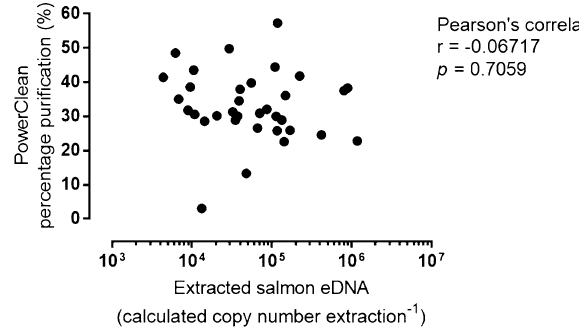
Figure 3. Calculated Chum salmon eDNA concentrations extracted by single or double DNeasy columns at ( A ) high (neat chum salmon seawater—2 L) and ( B ) low (10×-diluted chum salmon seawater—1 L) eDNA inputs (N = 2). Sterivex cartridges were extracted by Protocol 3 described in the text. Each column was eluted and chum salmon eDNA was quantified separately. Data is presented as mean with sample